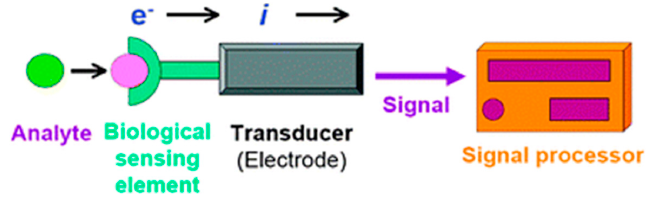
Figure 2. Scheme of a biosensor with an electrochemical transducer. Reprinted with permission from [10] Copyright (2010) Royal Society of Chemistry (RSC). from [10] Copyright (2010) Royal Society of Chemistry